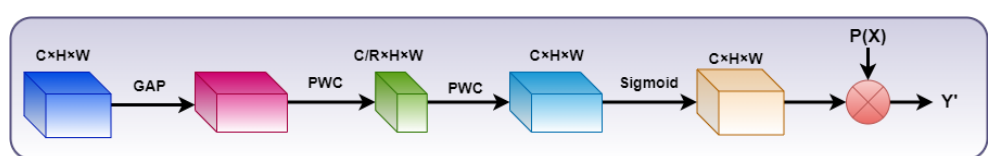
Figure 4. Illustration of pixel attention mechanism. The PA module is mainly used to reweight the feature